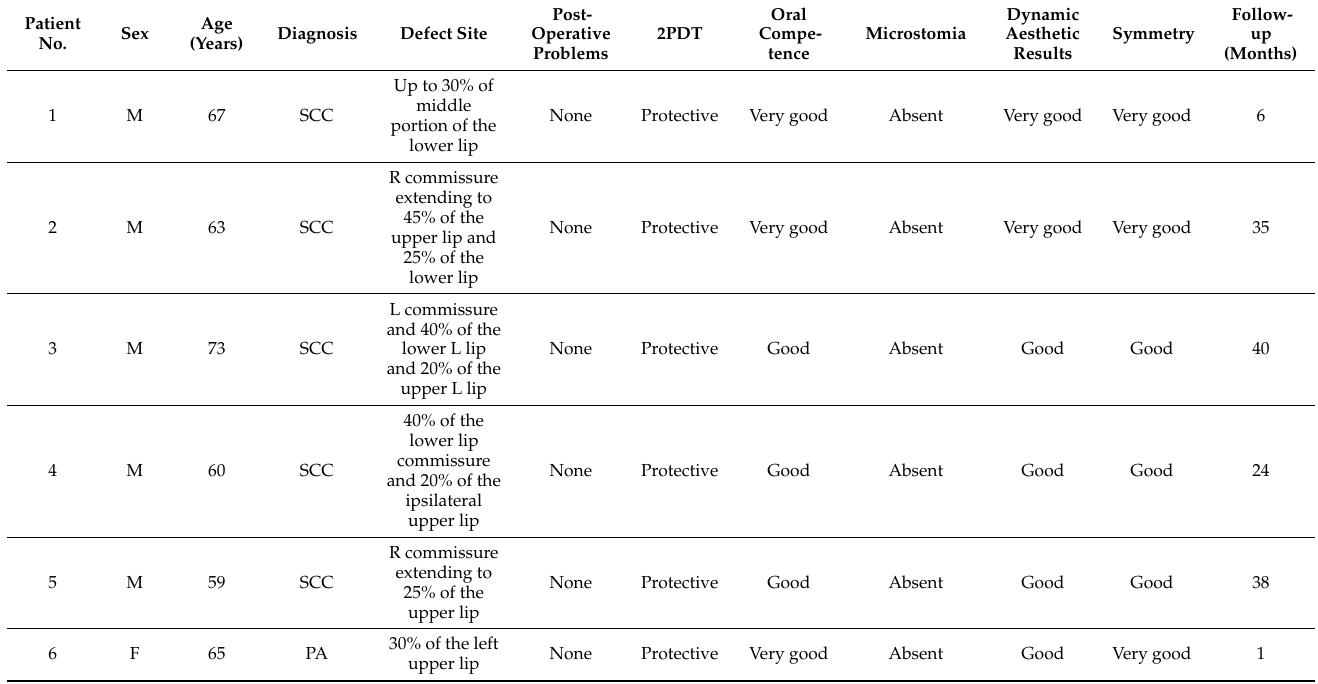
Table 1. Patients’ characteristics